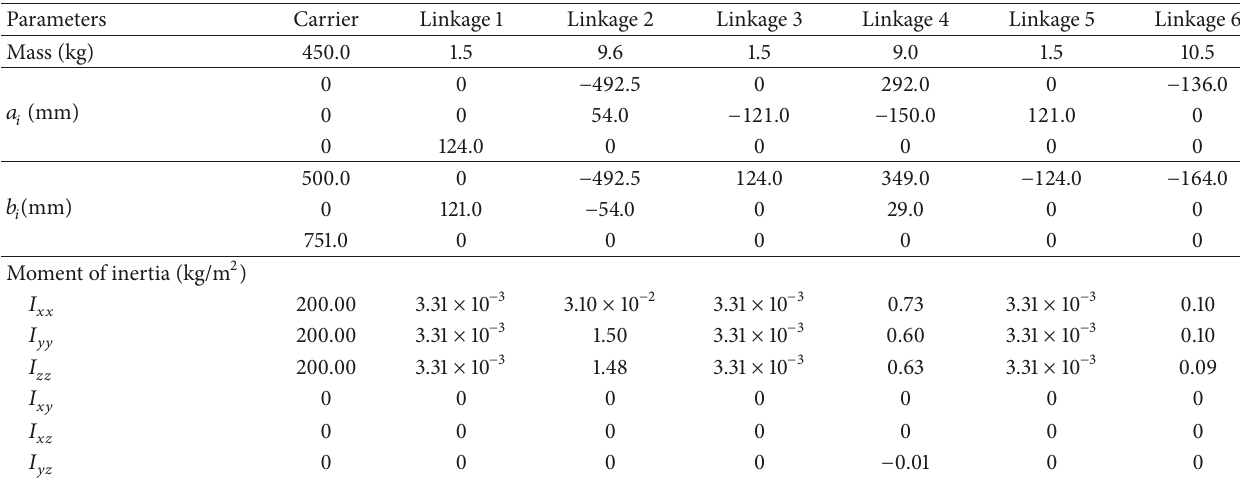
Table 1: Linkage parameters of the space